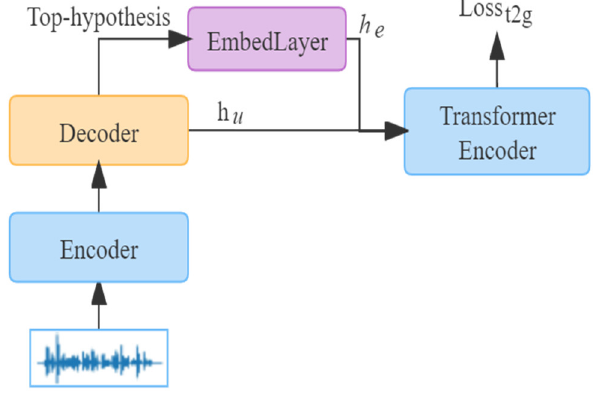
Figure 3. Text‑to‑grammar downstream Figure 3. Text-to-grammar downstream task.